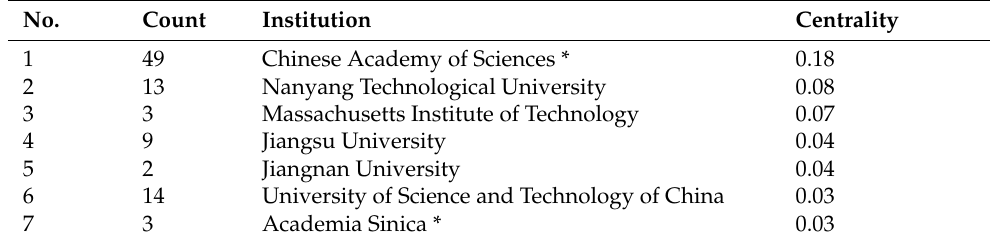
Table 3. A list of the top 7 institutions using centrality order for graphene-based SERS. No.